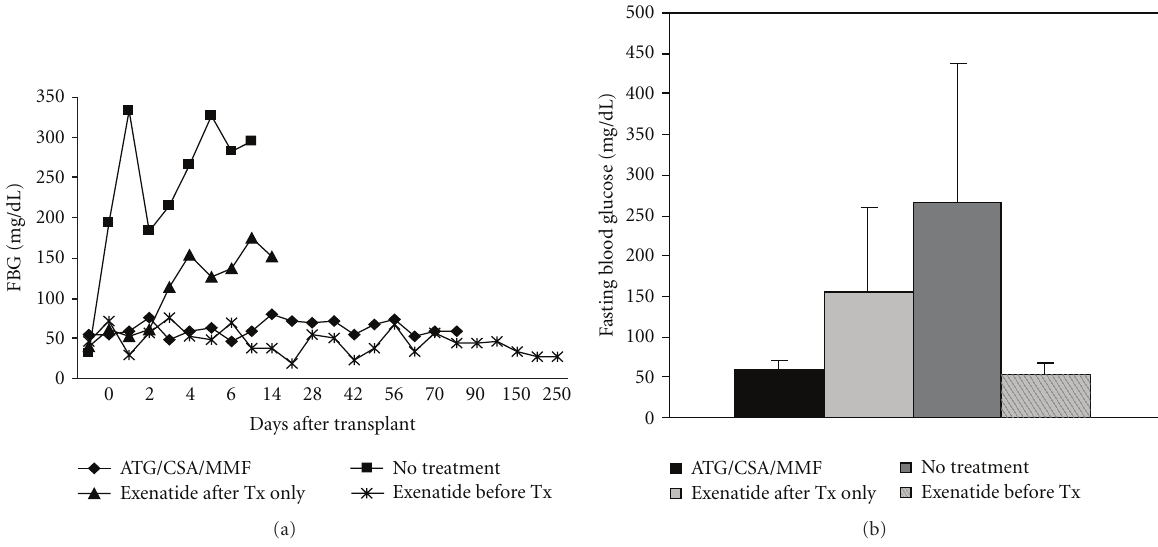
Figure 1: (a) Fasting blood glucose monitoring of transplanted animals. (b) Average fasting blood glucose levels measured at day 5 post- transplant. Untreated animals showed elevated blood glucose levels by day 1 posttransplant, animals treated with exenatide after transplant only showed somewhat elevated blood glucose levels beginning at day 4 posttransplant, while animals treated with ATG/CSA/MMF or pre- treated with exenatide remained normoglycemic throughout the study period. In fact, two animals from the exenatide pre-treatment group remained normoglycemic up to 435 days subsequent to